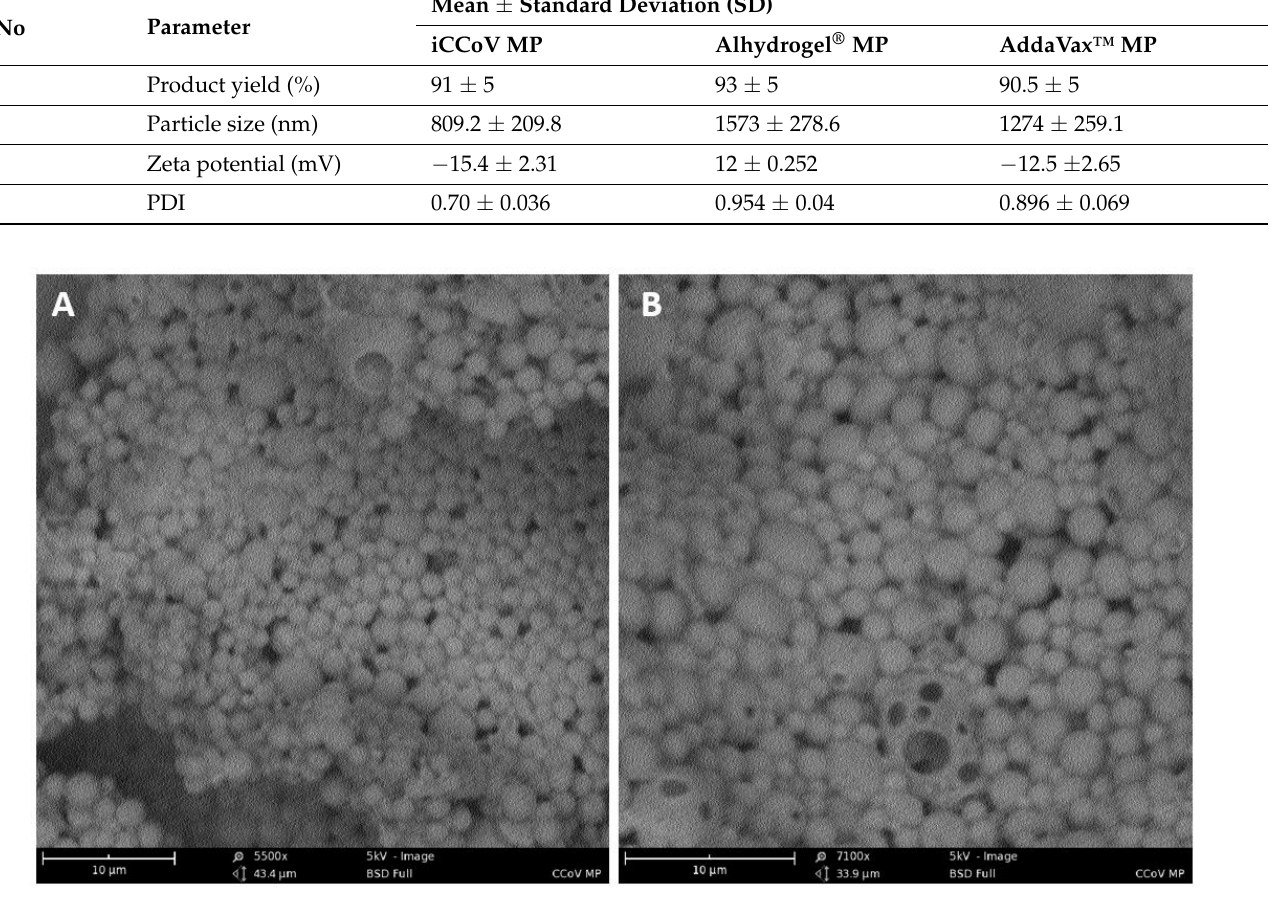
Figure 3. Characterization of MP . A. Scanning electron microscope image of MP at a magnification